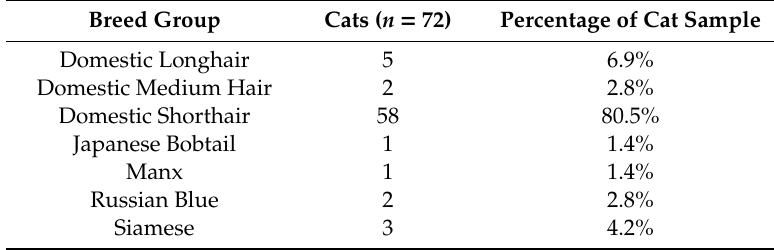
Table 4. Cat breed group by number of animals and percentage of the sample ( n = 72).